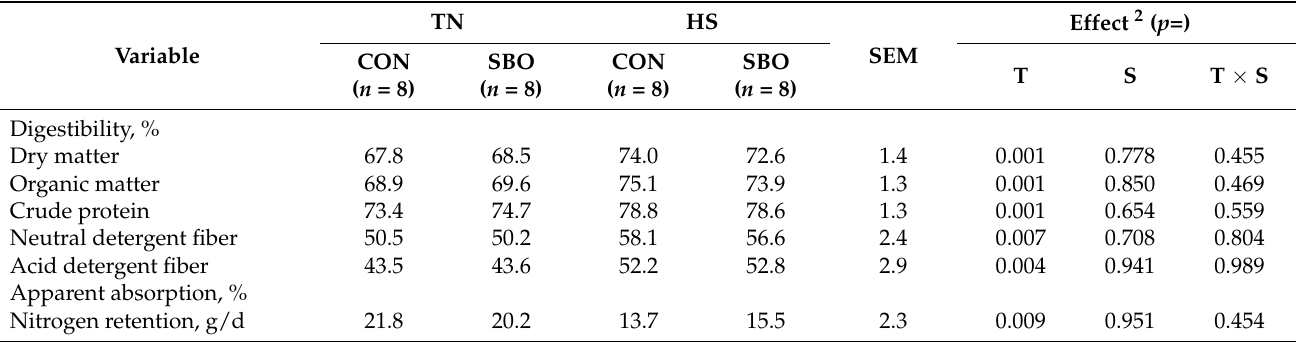
Table 4. Least squares means for digestibility coefficients and nitrogen retention of dairy goats under thermoneutral (TN) and heat stress (HS) conditions. In each ambient temperature, goats were fed a control diet (CON) or supplemented with 4% soybean oil (SBO) 1